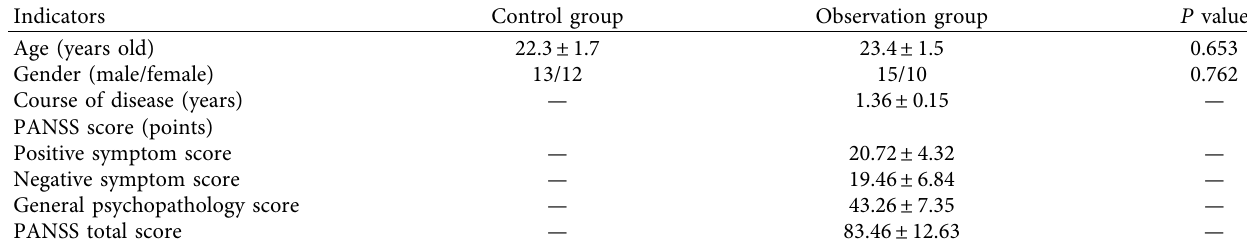
Table 1: Comparison on general clinic